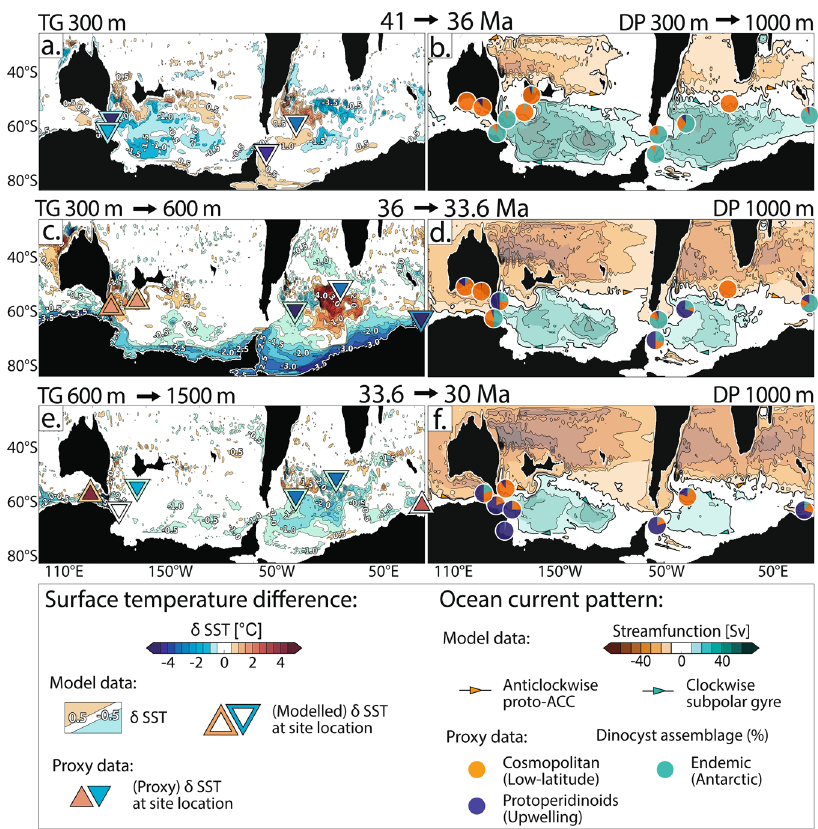
Fig. 3 Paleoceanographic evolution of the Southern Ocean. a – f Model-data comparison and proposed paleoceanographic evolution of the surface Southern Ocean from the Late Eocene to Early Oligocene (41 – 30 million years ago, Ma). The left column presents the comparison of observed and modelled surface temperature differences ( δ SST, both datasets use the same colour scale, see legend). Modelled differences in sea-surface temperatures result from the: a Drake Passage (DP) deepening from 300 to 1000m (Tasmanian Gateway (TG) remaining at 300 m), TG deepening from: b 300 to 600 m and c 600 to 1500 m (DP at 1000 m). Contours indicate 0.5 °C intervals. The inner part of the triangles shows relative changes of paleo sea-surface temperature proxy records from sediment drill cores within the geological time slices 2,21,29 – 36,42,43 . The outer part of the triangles shows the modelled SST changes at these drill sites. The right column presents the comparison of observed and modelled current pattern. Modelled stream function pattern (bold contours show 10 Sverdrup (Sv) and − 10 Sv; fi ne lines show >10 Sv and < − 10 Sv; colour scale, see legend, ACC = Antarctic Circumpolar Current) are taken from simulations with: b TG at 300 m, d TG at 600 m and f TG at 1500 m (DP at 1000 m; Fig. 2). Pie charts present plankton biogeographic patterns in proportions (colours and af fi nities, see legend) 5,19,21,42 – 45 found in sediment drill cores as proxy for surface current pattern. Details of the sites ’ paleolocations, recorded geological time periods, as well as all data used in this study are collated in the